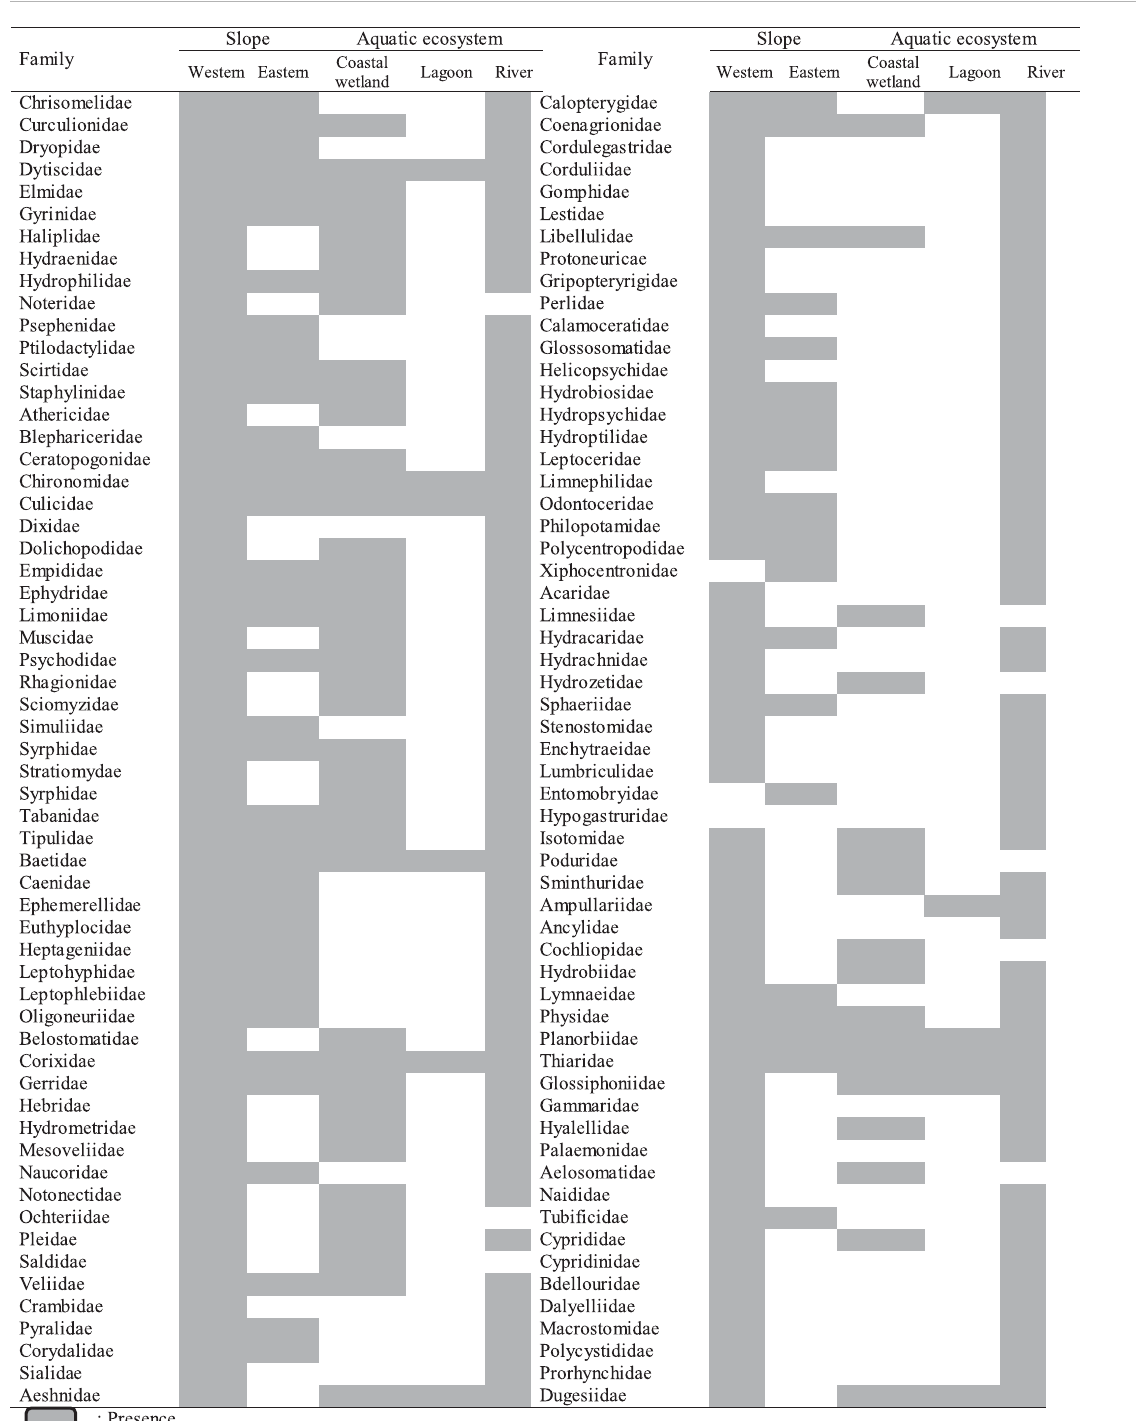
TABLE 6 | Families of macroinvertebrates by hydrographic slope and aquatic ecosystem, according to research studies carried out between years 1992 – 2020.